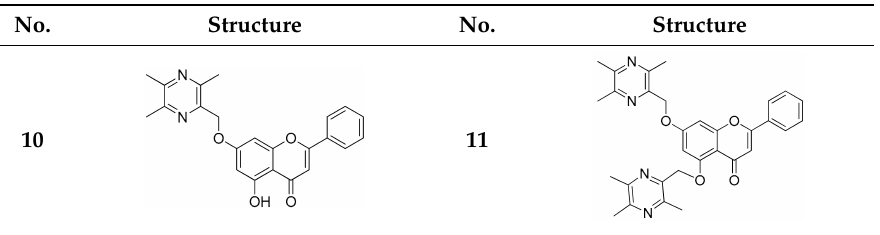
Table 2. The structures of ligustrazine-flavonoid derivatives 10 – 25